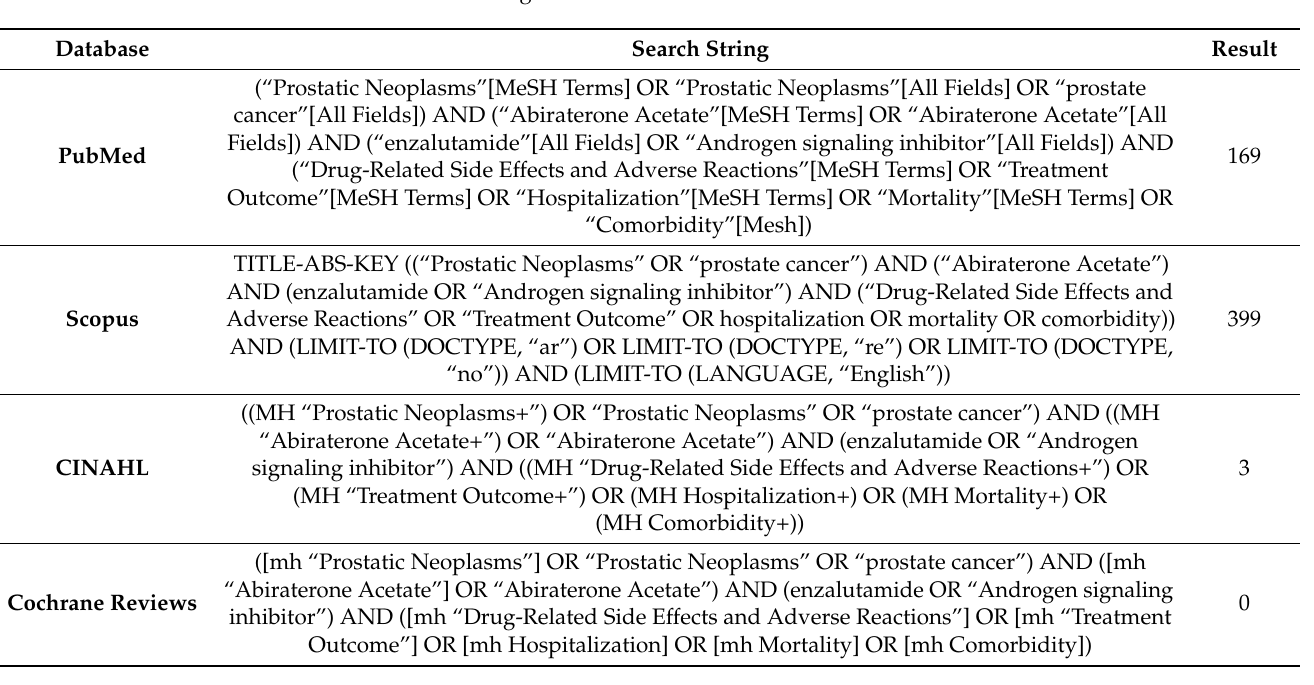
Table 1. Search strings